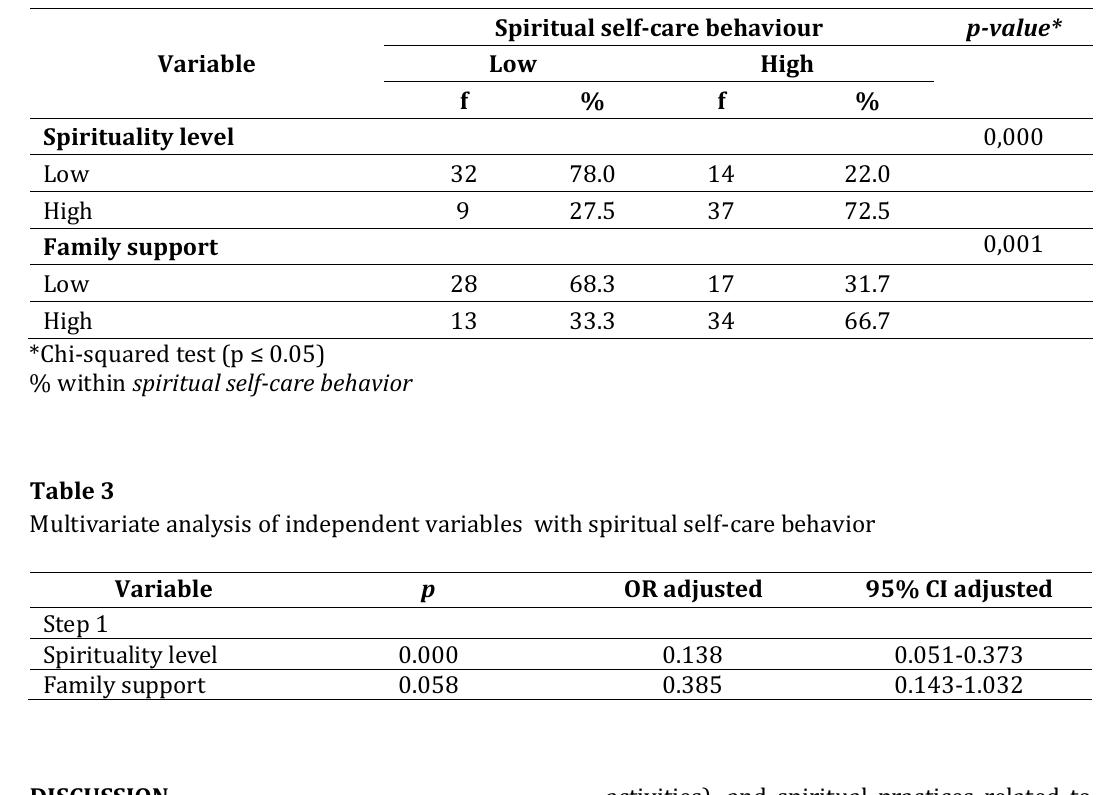
Relationship between spirituality level and family support with spiritual self-care behaviour